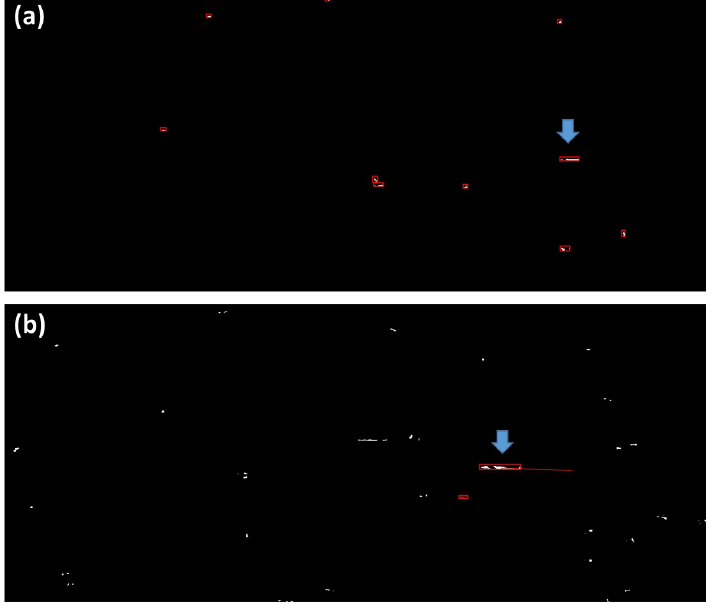
Figure 18. Tracking results of first image and 18th image. Blue arrow denotes the moving target. ( a ) is the first image, all ten clusters are used to initialize the tracks. The clusters correspond to the tracks and are labeled with red rectangles. ( b ) is the result of 18th image, the red line denotes the moving trace. It is clear that there are only two tracks which are updating after 18 iterations.